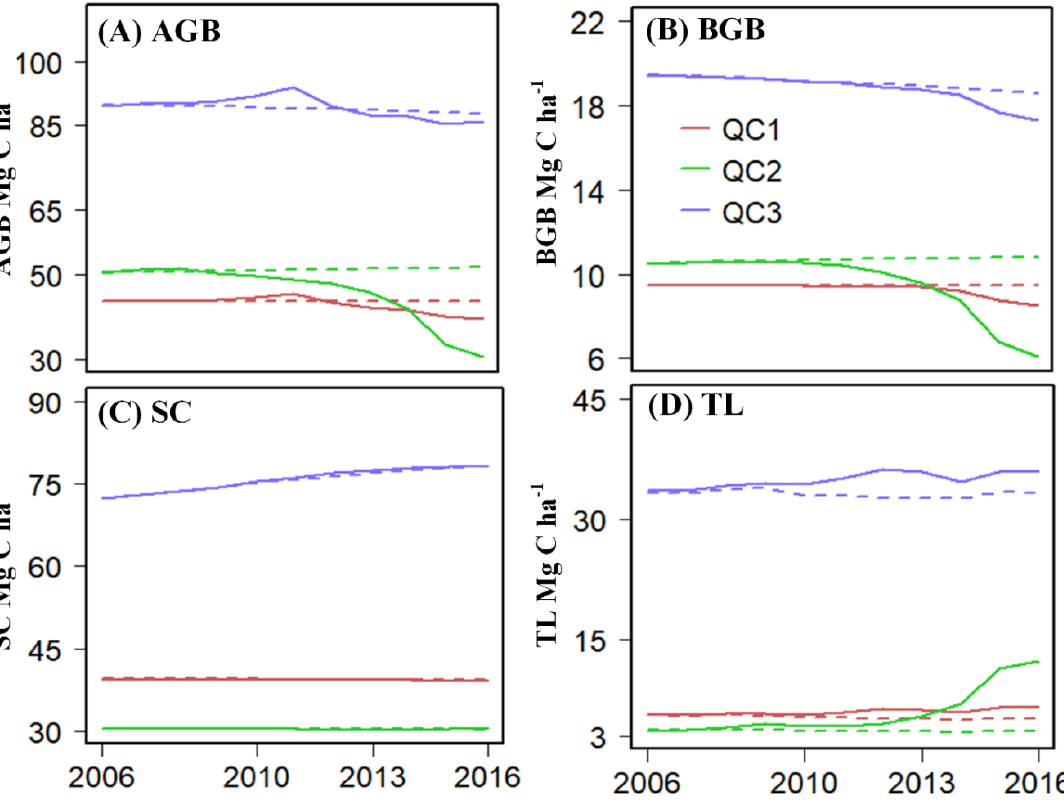
Figure 5. Simulated AGB ( A ), BGB ( B ), SC ( C ) and TL ( D ) on QC1, QC2 and QC3 plots from 2007 to 2017. Dotted lines represent results for no disturbance (control) and solid lines represent results for insect disturbance. Legend: AGB—aboveground tree biomass; BGB—belowground tree biomass; SC—soil organic carbon; TL—total litterfall.